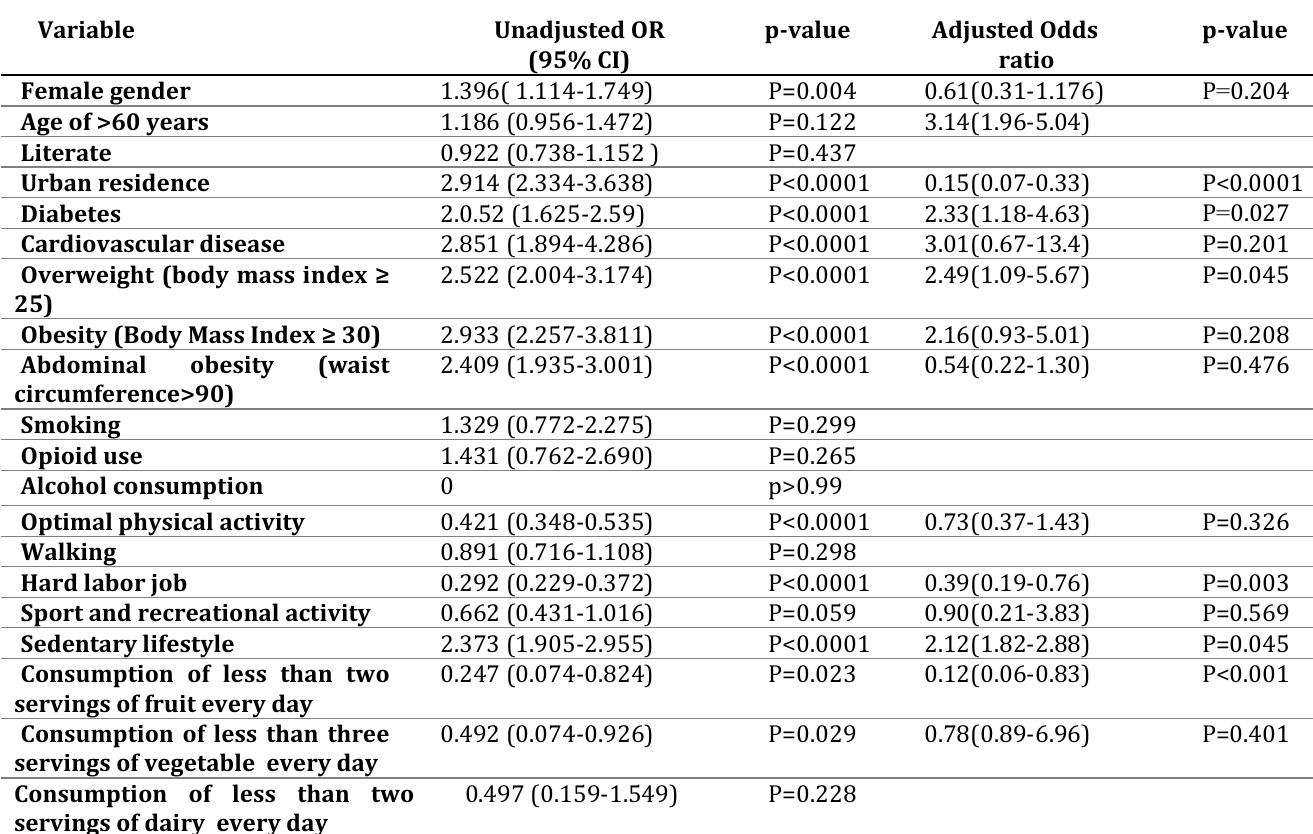
Table 2 . Relationship between the study variables and the risk of